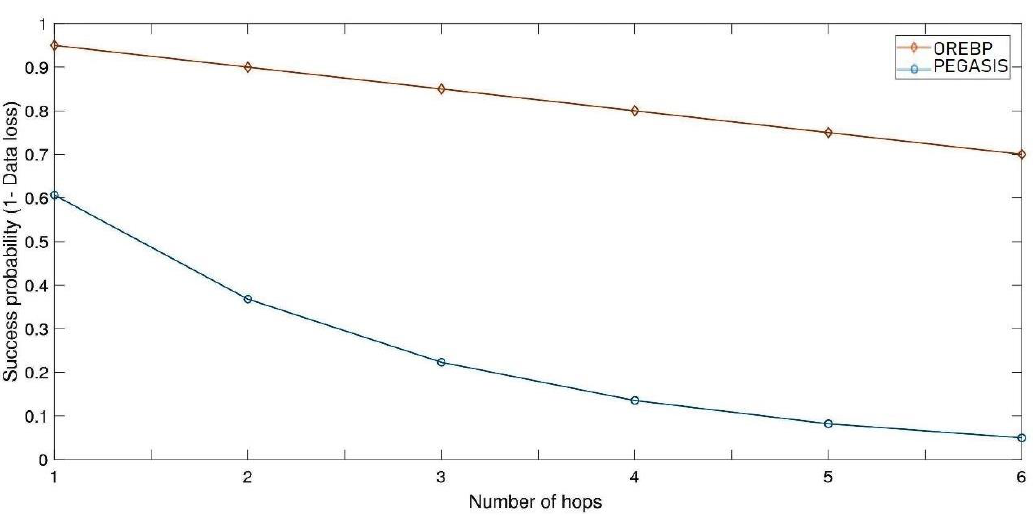
Figure 5. Success probability when data loss (𝜀 = 0.05) .